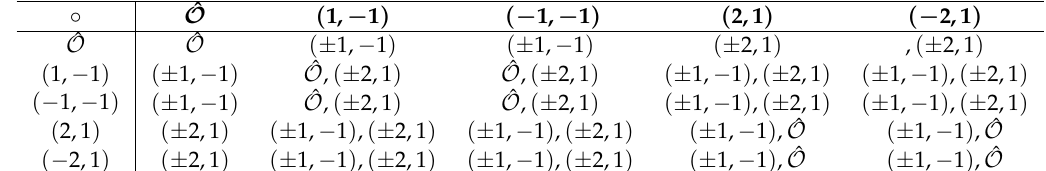
Table 3. Caley table